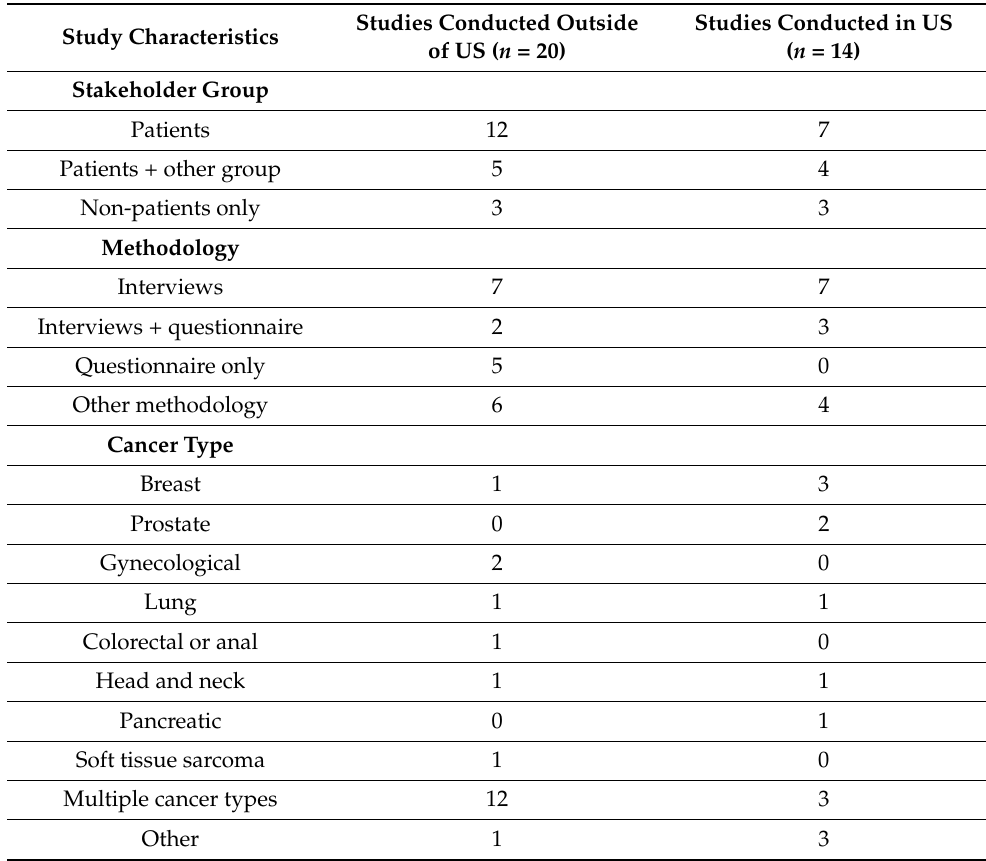
Table 1. Characteristics of 34 studies included in